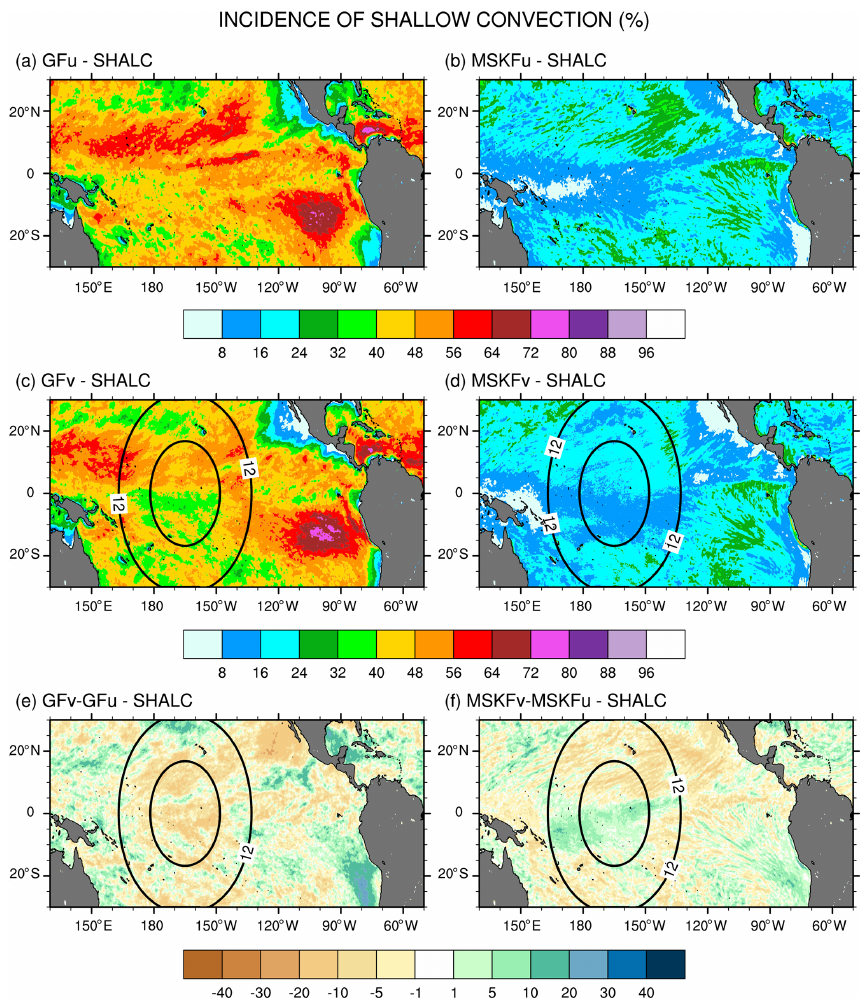
Figure 6. Monthly-mean incidence of shallow convection (SHALC) over the tropical Pacific Ocean simulated in (a, b) GFu and MSKFu and (c, d) GFv and MSKFv and difference in the incidence of shallow convection between (e) GFv and GFu and (f) MSKFv and MSKFu for December